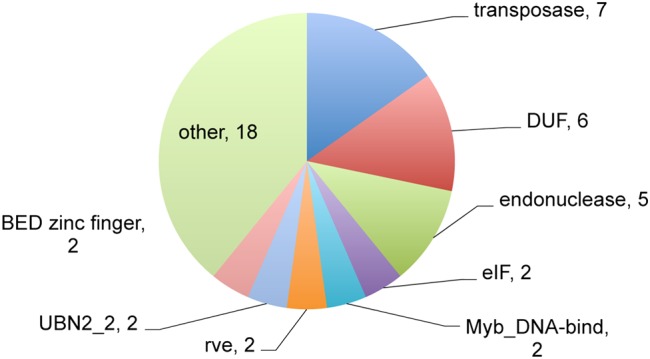
Domain search of products from newly identified genes. The pie chart represents the number of genes predicted to include encode the different domains. Newly identified genes were classified based on the domains predicted using the NCBI CDD (conserved domains database; http://www.ncbi.nlm.nih.gov/cdd). DUF, domain of unknown function; eIF, eukaryotic translation initiation factor; rev; integrase core domain; UBN, gag-polypeptide of LTR copia-type.